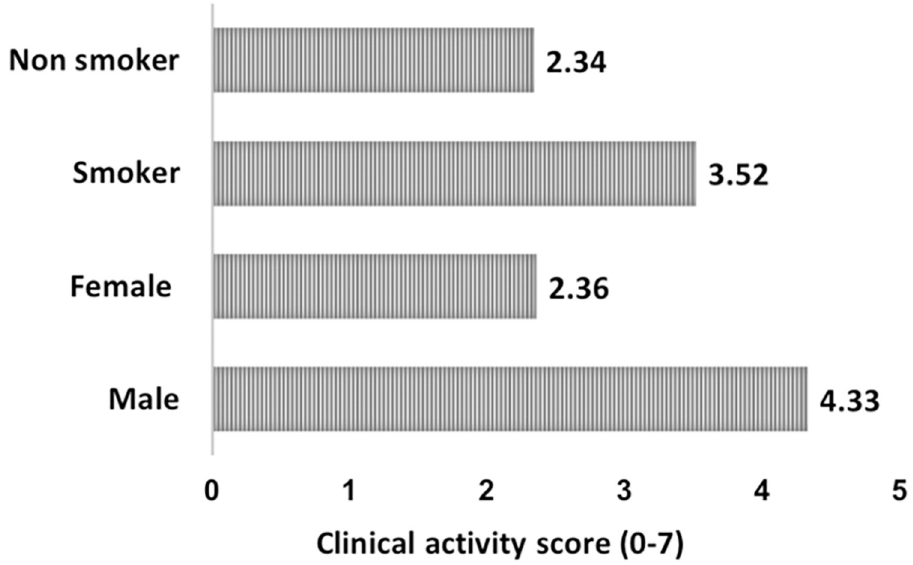
Fig 1. The mean of clinical activity score (CAS) in different groups with Graves’ ophthalmopathy. The mean CAS score was significantly higher in males than in females ( P = 0.008). The mean CAS score in smokers with GO was higher than that in non-smokers, with no statistically significant differences ( P = 0.872).